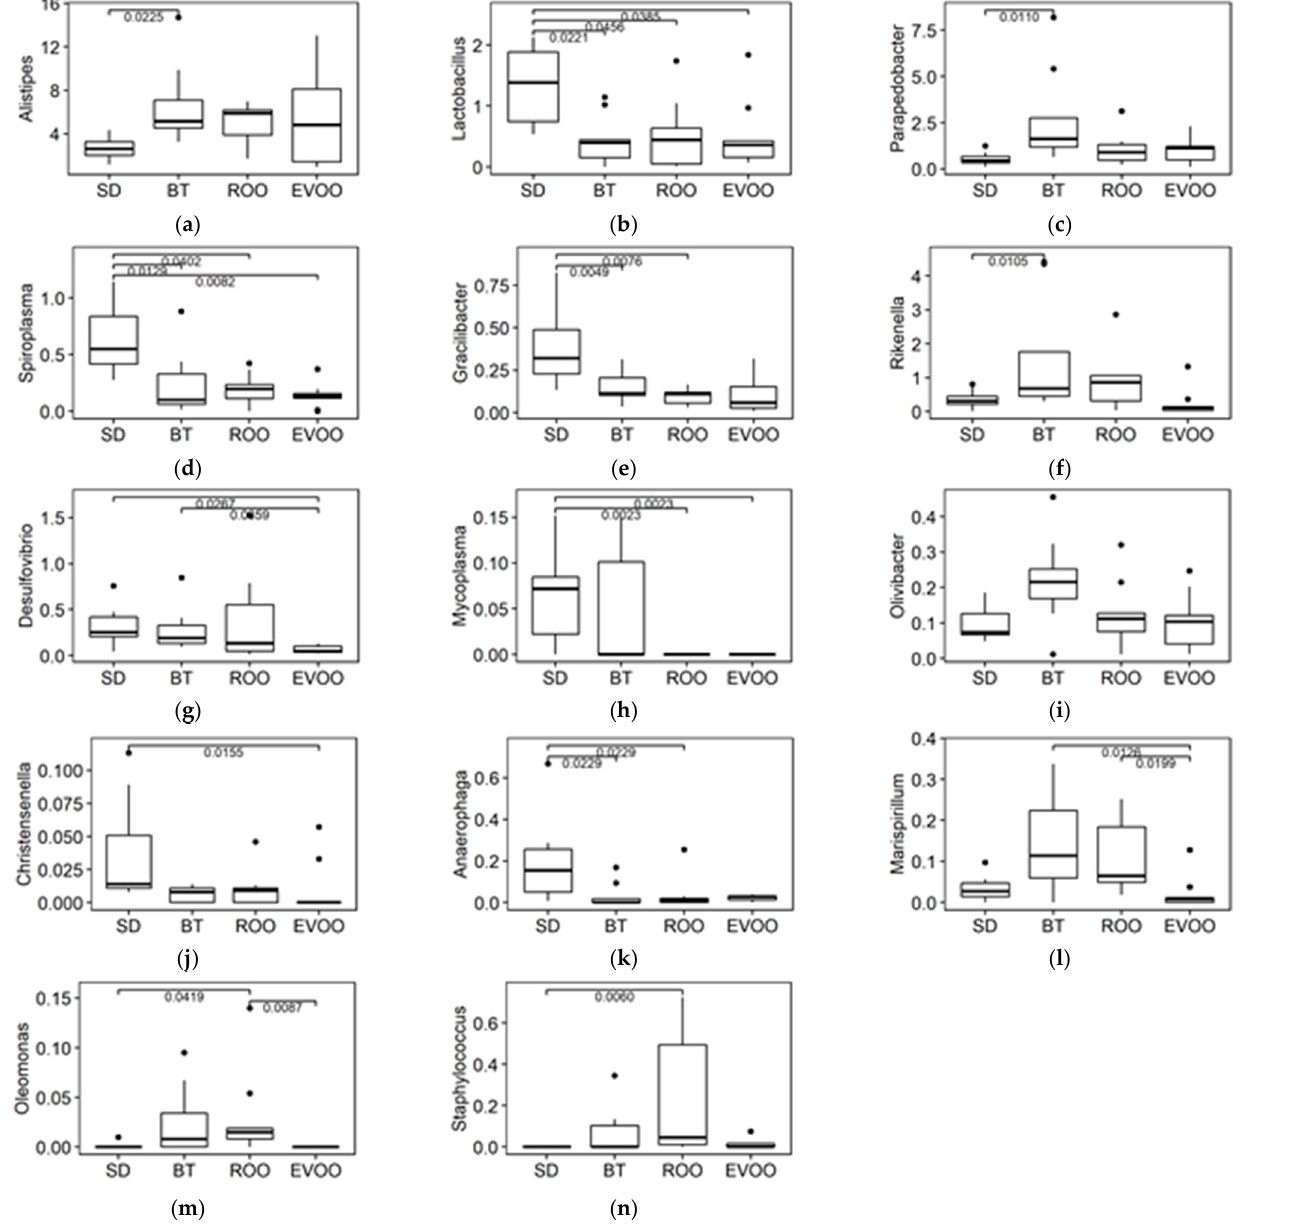
Figure 5. Box plot representation of the percentage distribution of the fourteen genera ( a ) Alistipes , ( b ) Lactobacillus , ( c ) Parapedobacter , ( d ) Spiroplasma , ( e ) Gracillibacter , ( f ) Rikenella , ( g ) Desulfovibrio , ( h ) Mycoplasma , ( i ) Olivibacter , ( j ) Christensenella , ( k ) Anaerophaga , ( l ) Marispirillum , ( m ) Oleomonas , ( n ) Staphylococcus , with significant differences ( p < 0.05) among fecal samples from mice fed a diet enriched with butter (BT), extra virgin olive oil (EVOO), refined olive oil (ROO), or standard chow (SD). Adjusted p -values of significant pairwise comparisons are also shown. SD, EVOO, and BT diet values from [17]. Table 2. Regression fits for each of the physiological variables studied using as independent varia- bles those genera that show statistical differences in the percentage of sequences retrieved from fecal samples. BW, body weight; FI, food intake, WI, water intake; SBP, systolic blood pressure.